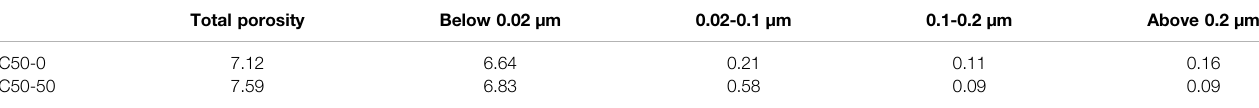
TABLE 9 | Porosity of concrete